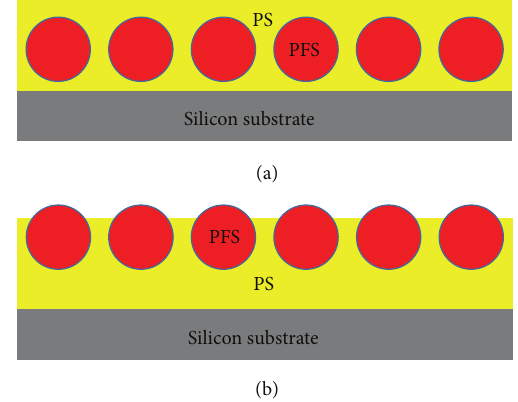
Scheme 1: Schematics of the possible structures of PS- b -PFS thin films on a substrate, (a) PFS cylinders contained within the PS matrix, and (b) PFS cylinders exposed at the